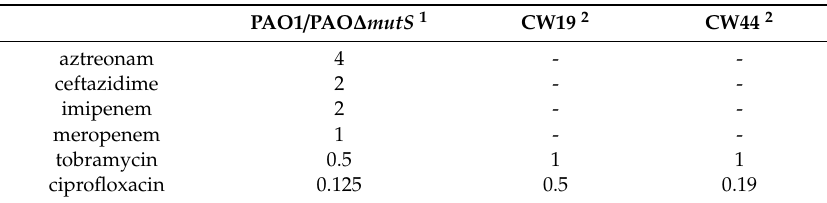
Table 1. Minimum inhibitory concentrations (MICs). The MIC values of the antibiotics used against hypermutable and non-hypermutable Pseudomonas aeruginosa